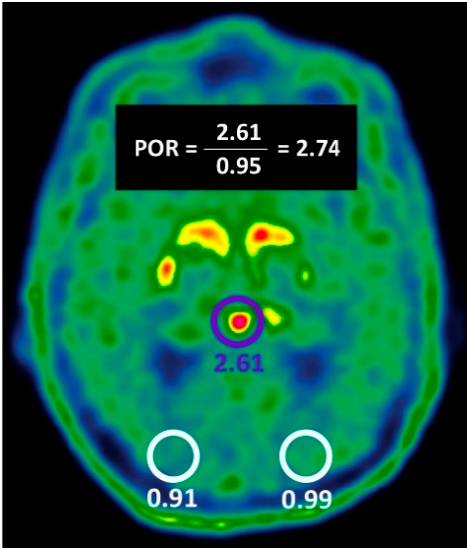
Figure 4. Illustration of POR calculation. VOIs are drawn on the pineal body and the right and left occipital cortices. The SUVmax in the pineal body VOI (purple), and the SUVmean values in the occipital cortices VOIs (white) are recorded. Pineal to occipital cortex uptake ratio (POR) is calculated as the ratio between the SUVmax value in the pineal body and the average SUVmean values in the occipital cortex. Based on the present study, POR value ≥ 1.57 was associated with the diagnosis of nigrostriatal